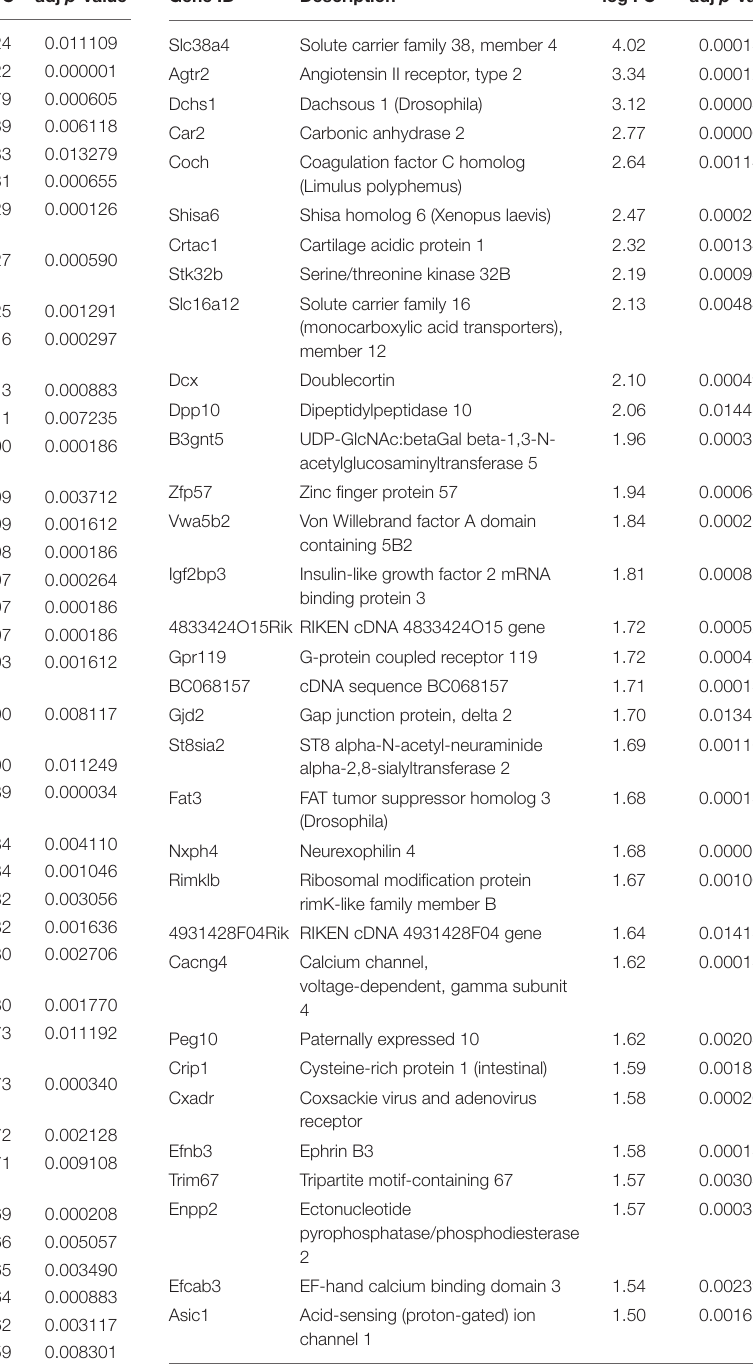
TABLE 3 | Most significantly down-regulated genes in the 21DIV compared to 5DIV SCG neurons (adjusted p < 0.01 , log fold change >